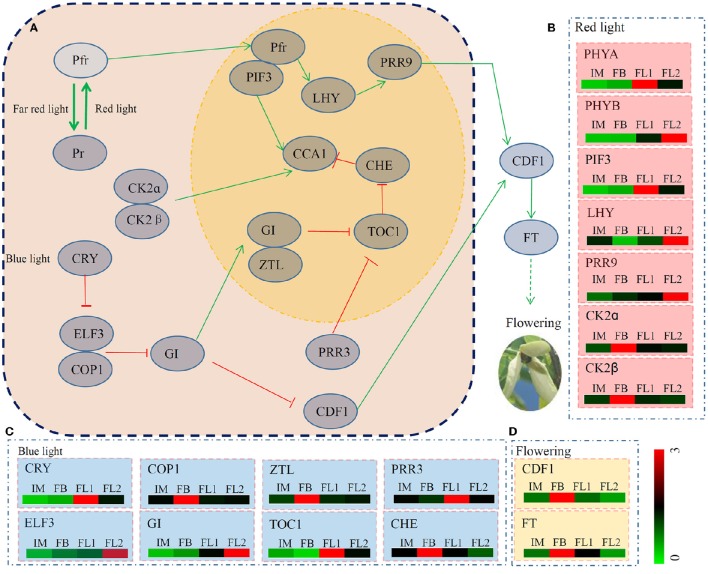
The detailed information on genes involved in the pathway of circadian rhythm. (A) The putative regulation network of circadian clock associated with flowering in sugar apple. Red arrow indicated depressing; and green arrow indicated activating. (B) The expression pattern of red light signaling pathway related genes during the flowering process. (C) The expression pattern of blue light signaling pathway related genes during the flowering process. (D) The expression pattern of two key flower development regulation genes during the flowering process. The different colors correspond to the log-transcription values of RPKM refer to each gene shown in the bar at the lower right corner of the figure.